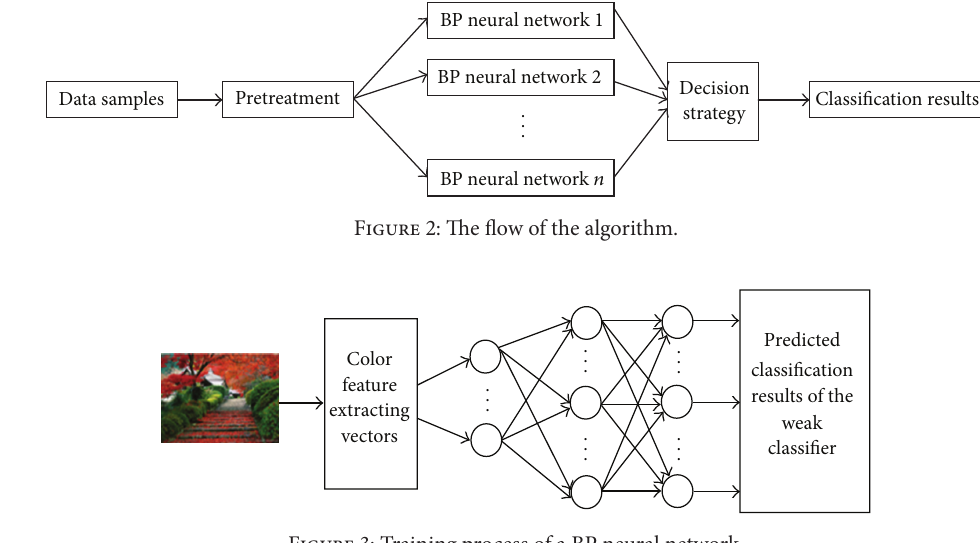
Figure 3: Training process of a BP neural network.